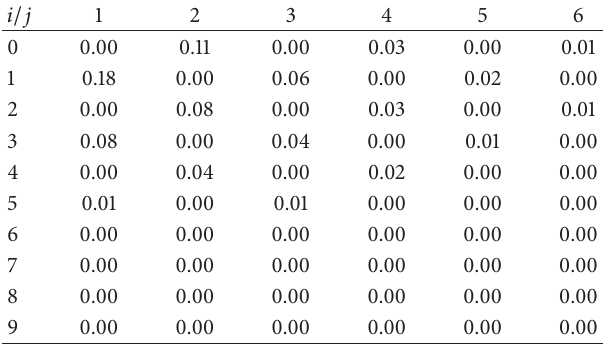
Table 4: Standard deviation of amplitudes, in Table 2 and Figure 5.